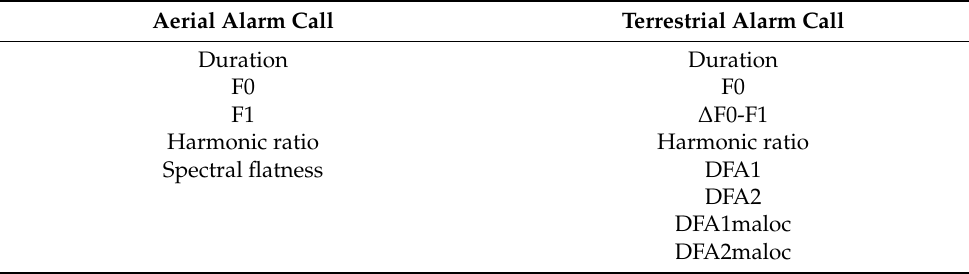
Table 3. Features selected via the LASSO algorithm per alarm call type. Feature abbreviation: Duration, duration of the vocalization; F0, fundamental frequency; F1, first formant; ∆ F0-F1, delta between F0 and F1; Harmonic ratio, describes how harmonic or noisy a signal is; Spectral flatness, quantify how tone-like or noise-like a sound is; DFA1, frequency at which the energy reaches the first quartile; DFA2, frequency at which the energy reaches the second quartile; DFA1maloc, location of the maximum frequency in the first quartile; DFA2maloc, location of the maximum frequency in the second quartile. A list of all used features can be found in Table S1. Aerial Alarm Call Terrestrial Alarm Call Duration Duration F0 F0 F1 ∆ F0-F1 Harmonic ratio Harmonic ratio Spectral flatness DFA1 DFA2 DFA1maloc